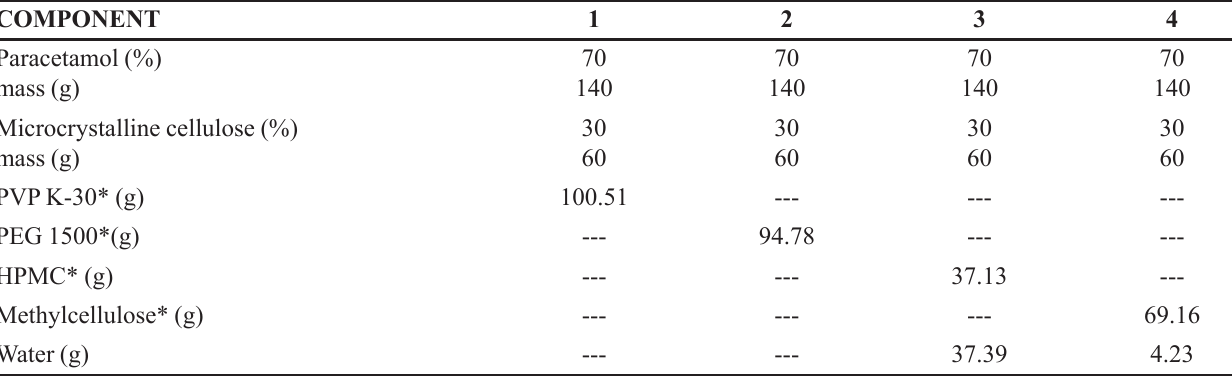
TABLE I - Qualitative and quantitative composition of the pellet formulations produced